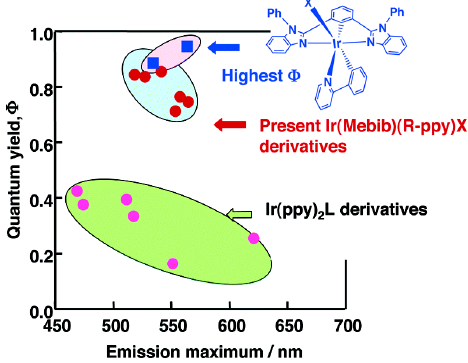
Figure 6. Structure of mix-ligand Ir(III) complex with emission spectra [81] [Adapted with permission from (Obara et al.). Copyright (2006) American Chemical Society].